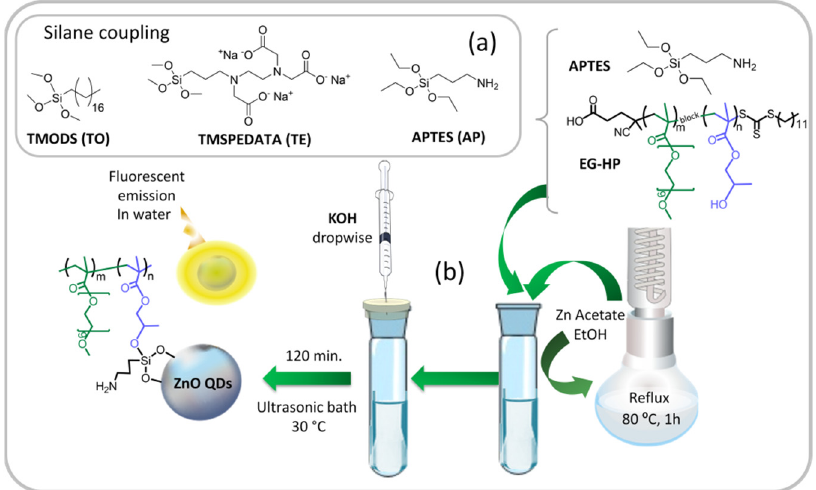
Scheme 2. ( a ) Silane coupling agents for the synthesis of hybrid ZnO QDs. ( b ) Procedure for the synthesis of ZnO QDs protected with a mixture of APTES and EG-HP block copolymer. Table 3. Synthetic conditions, hydrodynamic diameter, and photophysical properties of ZnO QDs synthesized in the presence of three silane coupling agents: TMODS (TO), TMSPEDATA (TE), and APTES (AP).